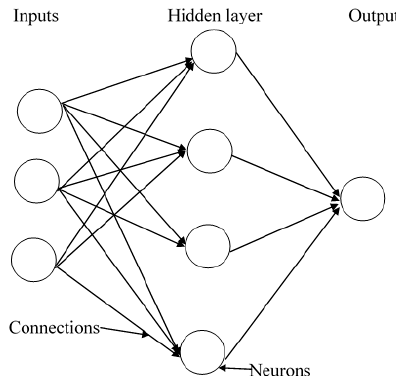
Figure 1. Architecture of a neural network with a single hidden layer.